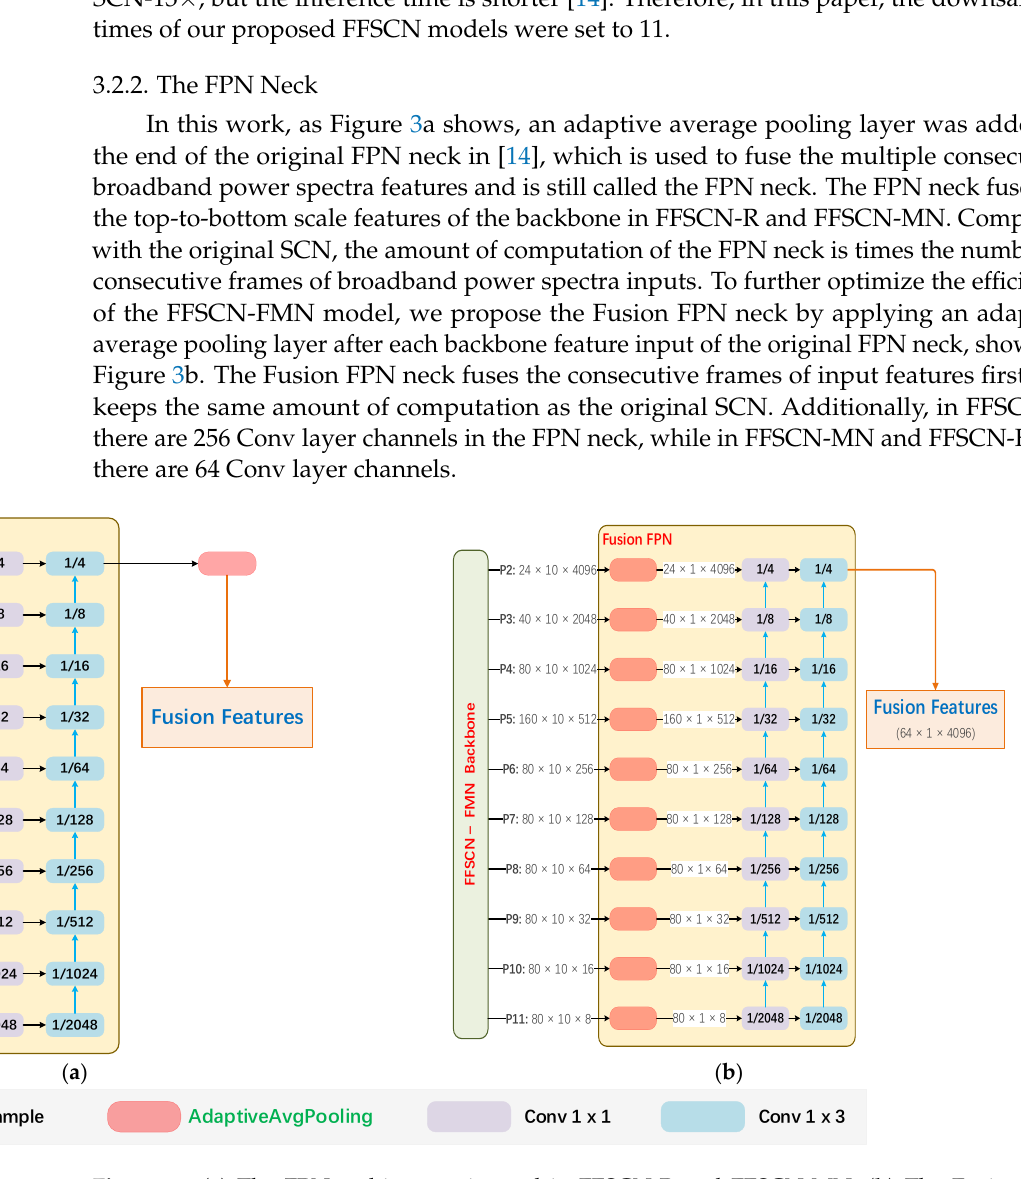
Figure 3. ( a ) The FPN architecture is used in FFSCN-R and FFSCN-MN. ( b ) The Fusion FPN architecture is used in FFSCN-FMN.